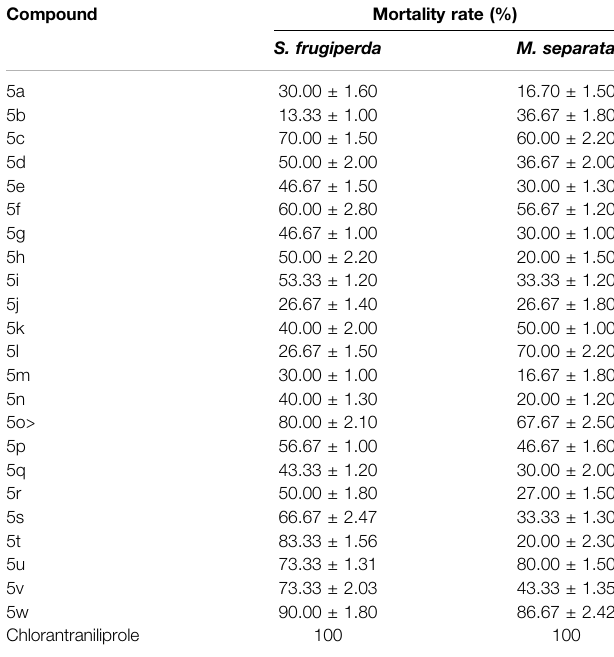
TABLE 2 | The insecticidal activities of the title compounds 5a − 5w at 500 μ